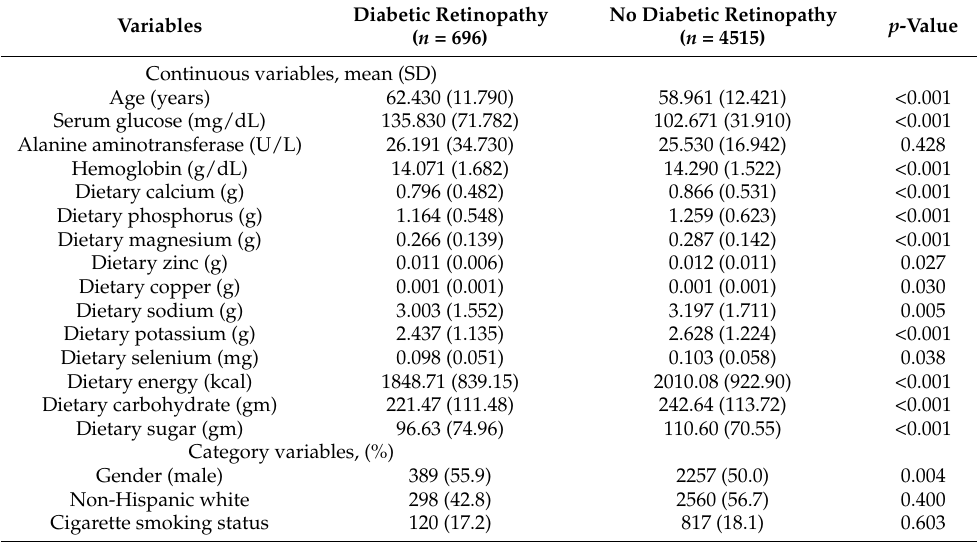
Table 1. Characteristics of Study